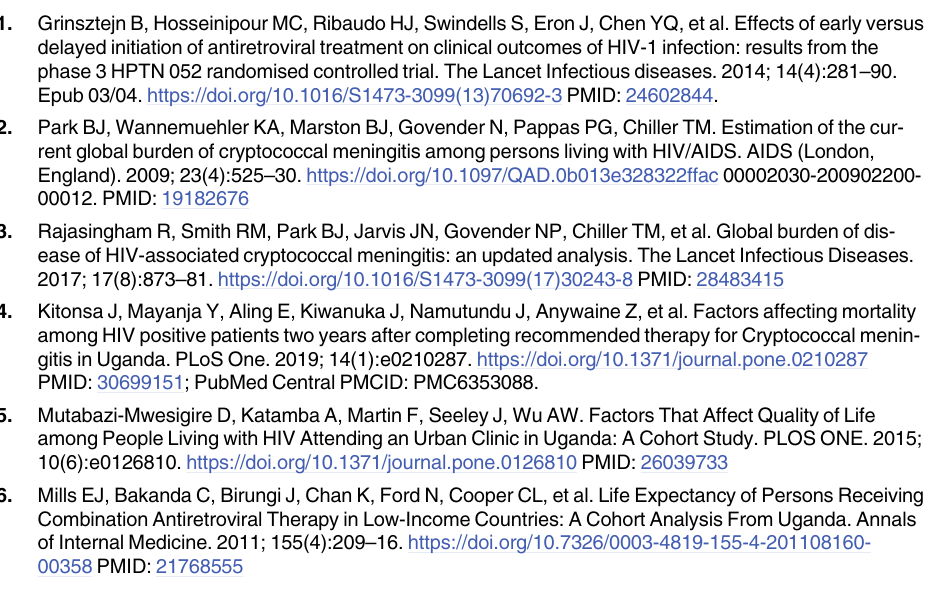
S1 Table. Is showing comparison of baseline characteristics of the patients that had QoL evaluation at 10 weeks (n = 238) and those that did not (n =